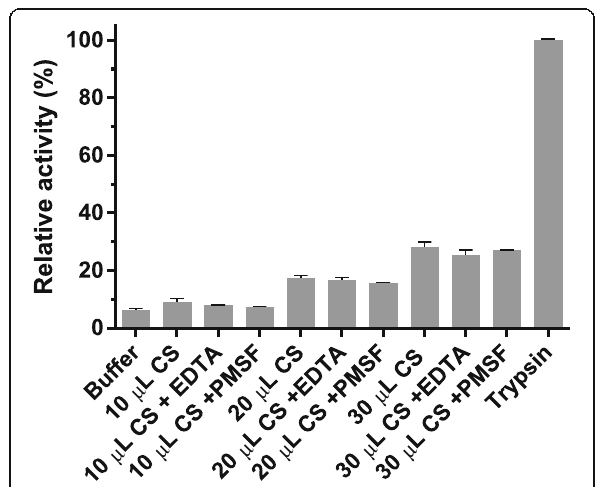
Fig. 4 Caseinolytic activity assay. Azocasein degradation was determined spectrophotometrically. Different volumes of CS were incubated in presence of EDTA or PMSF. Buffer was used as negative control and Trypsin as positive control. The degradation was measured in triplicate and normalized to relative activity compared to